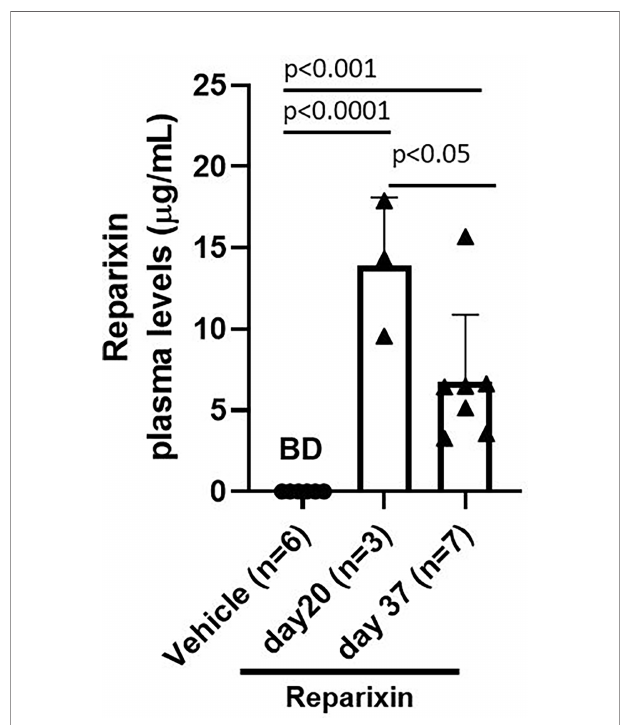
FIGURE 3 | Plasma levels ( m g/ml) of Reparixin detected at days 20 and 37. Plasma levels of Reparixin were signi fi cantly higher in Gata1 low mice scari fi ed at day 20 as compared to those sacri fi ced at day 37. Data are presented as Mean (± SD) and are analyzed by Tukey ’ s multiple comparisons test. Dots represent values observed in the individual mice. P < 0.05 was considered statistically signi fi cant. Abbreviations: BD, below detectable levels (i.e., <20% of the lower limit of quantitation (0.2